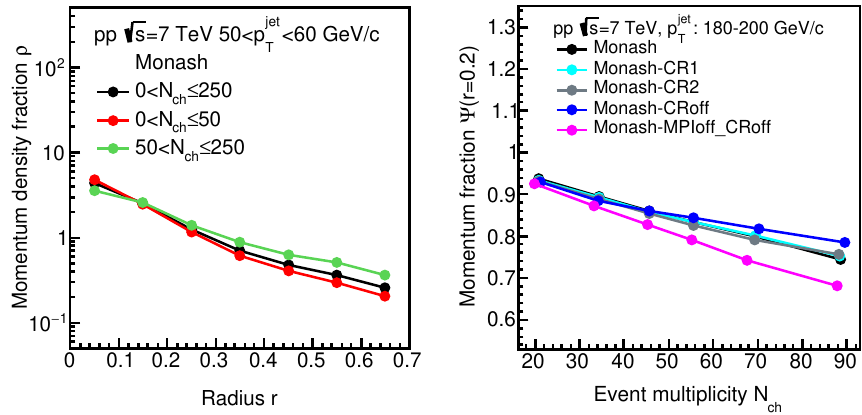
Figure 1. ( Left ) The differential jet structure for low and high multiplicites. ( Right ) The integral jet structure at r = 0.2 plotted against N ch for different MPI and CR simulation settings